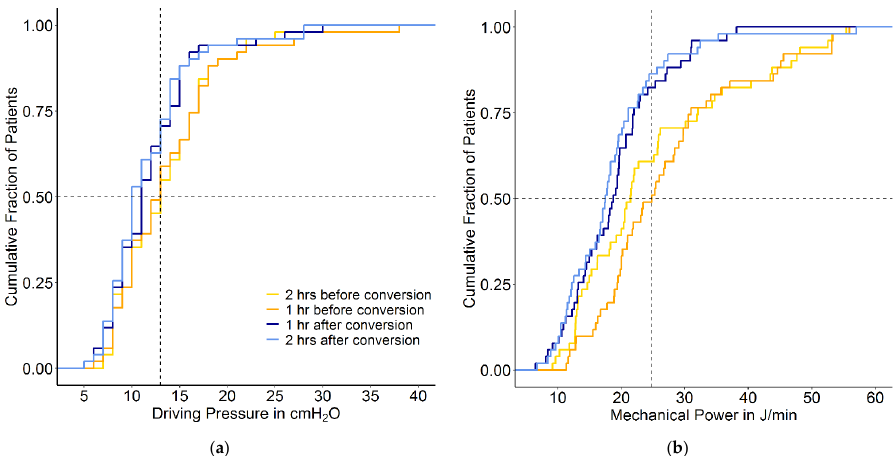
Figure 2. Cumulative frequency distribution of ( a ) Δ P and ( b ) MP. The plots show Δ P and MP 2 and 1 h before the conversion and 1 and 2 h after the conversion from conventional ventilation to INTELLiVENT-ASV. Vertical dotted lines represent the median at the last hour before the conversion, and horizontal dotted lines show the respective proportion of patients reaching each cutoff.